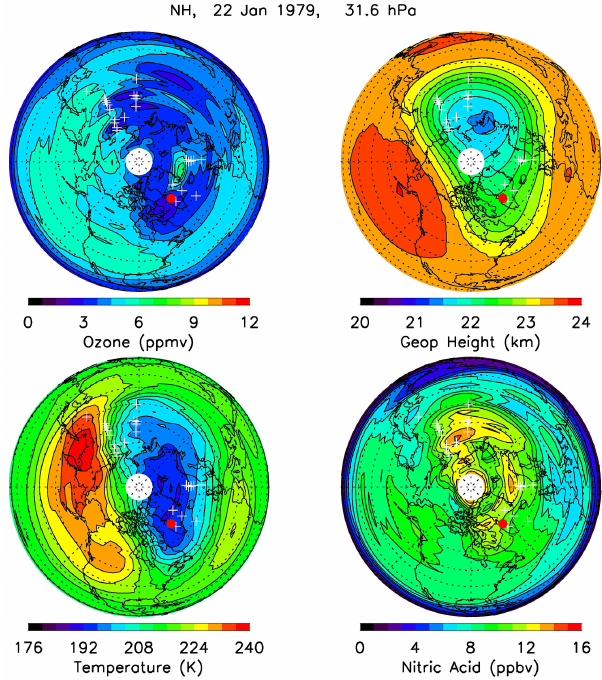
Figure 6. As in Fig. 2, but for 22 January 1979.